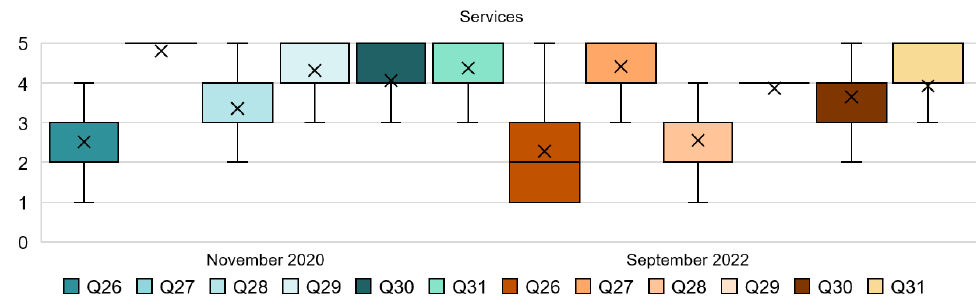
Figure 11. Interval data graph of the Services dimension.